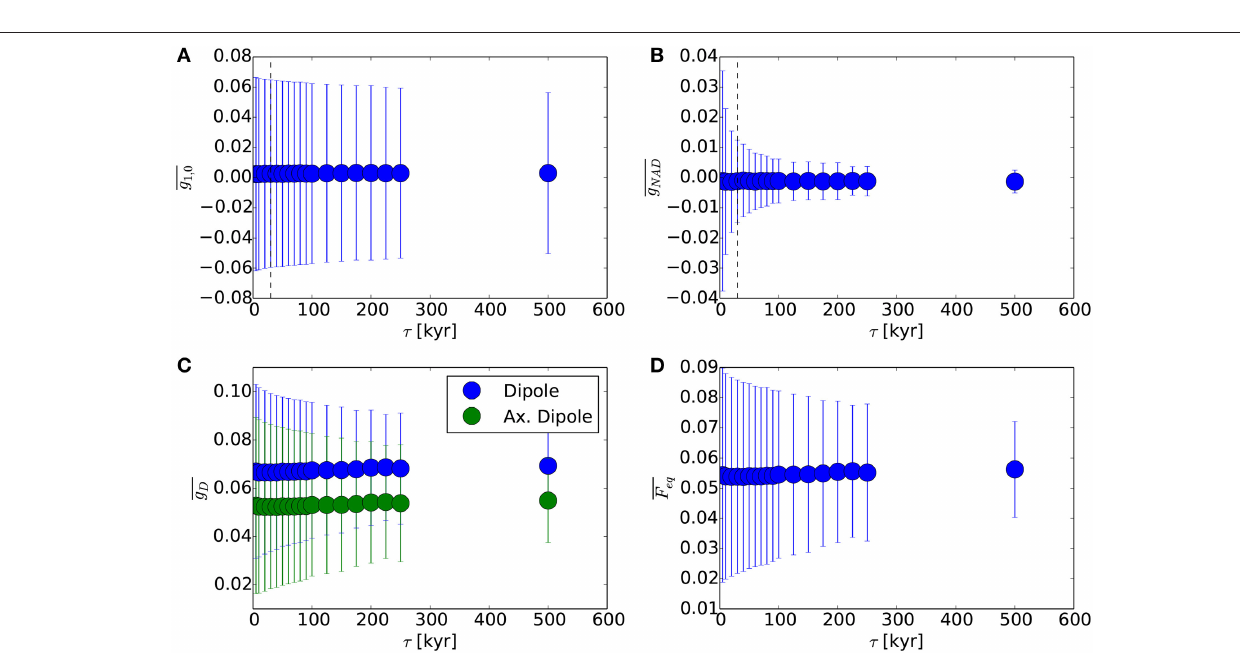
amplitude to g AD . A more comprehensive comparison between observed and true intensities as a function of co-latitude is